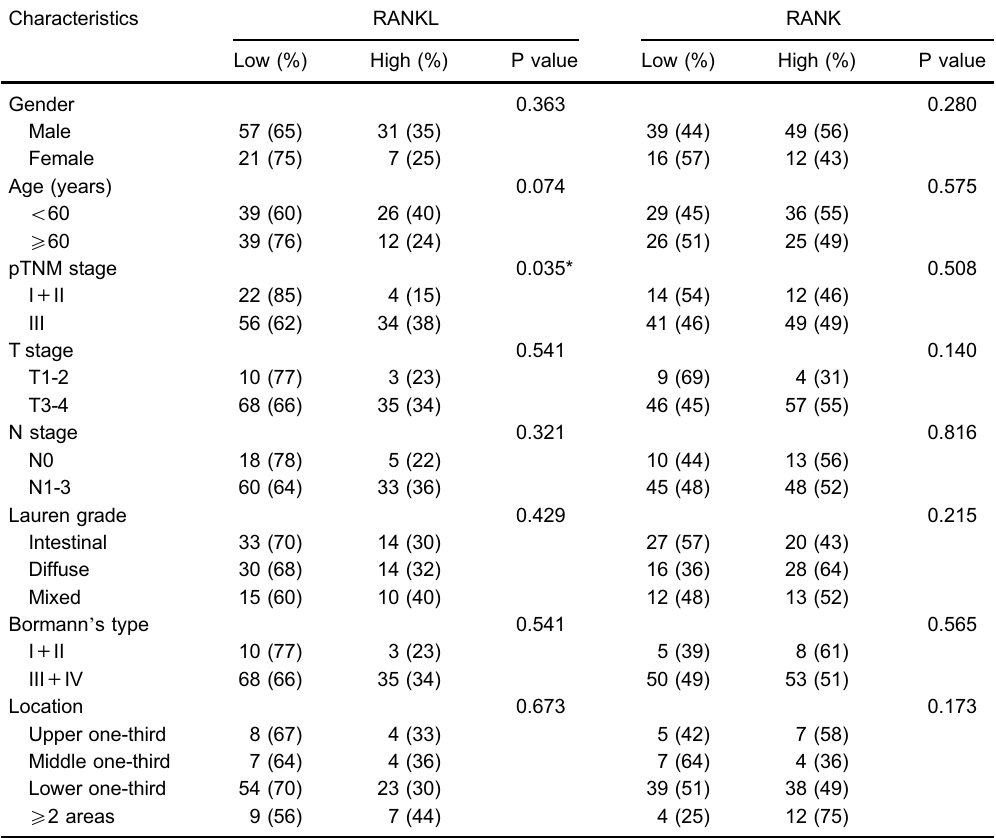
Table 1. Correlation between the expression of RANKL/RANK and the clinicopathological factors in primary gastric cancer patients. Characteristics